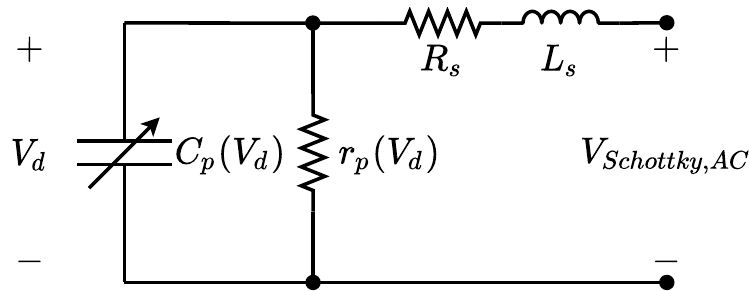
Figure 9. The AC small-signal